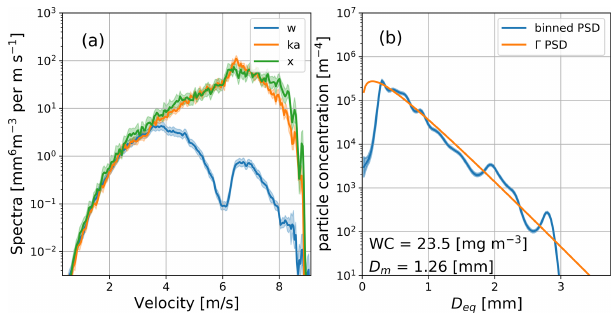
Figure 3. (a) Doppler spectra measured in rain just below the melt- ing zone at 07:01:34UTC. The green, orange and blue lines cor- respond to X-, Ka- and W-band data, respectively. The shaded ar- eas represent the measurement uncertainties. (b) The correspond- ing binned DSD retrieval (blue) and the best fit gamma DSD (or- ange). The x axis is the melted-equivalent diameter. The water con- tent (WC) and mass-weighted mean diameter ( D m ) corresponding to the binned DSD are shown as text in the